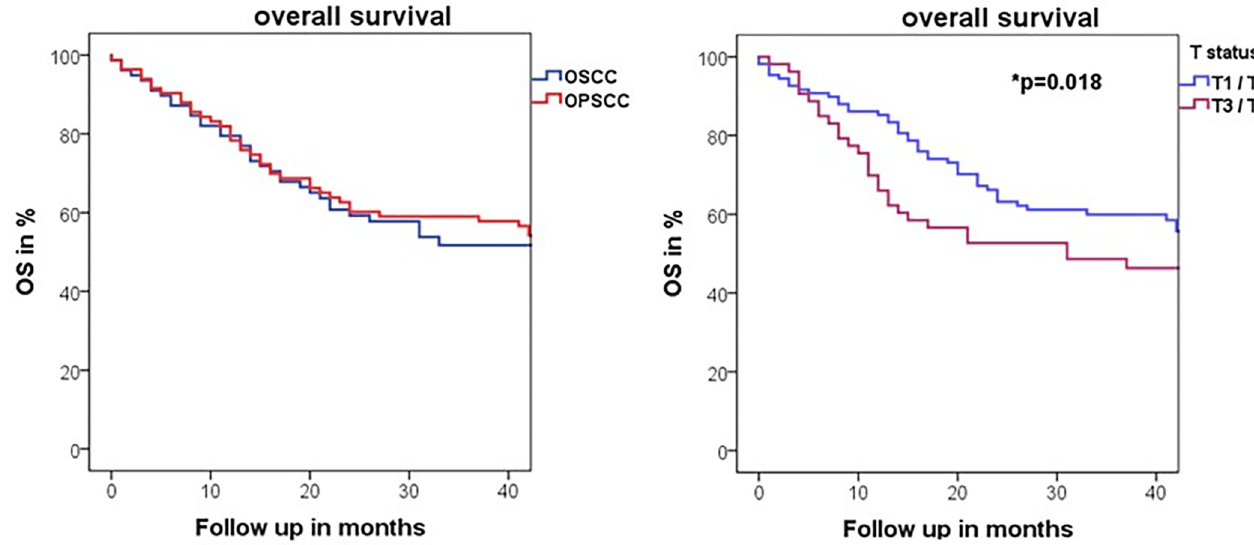
Fig 2. Kaplan-Meier curve illustrating A) Overall survival (OS) in respective of HNSCC subentity (OSCC blue, OPSCC red, p = 0.379) and B) significant influence of advanced T-Status on OS in both entities (T1/2 (blue) vs. T3/4 (purple), p = 0.011).